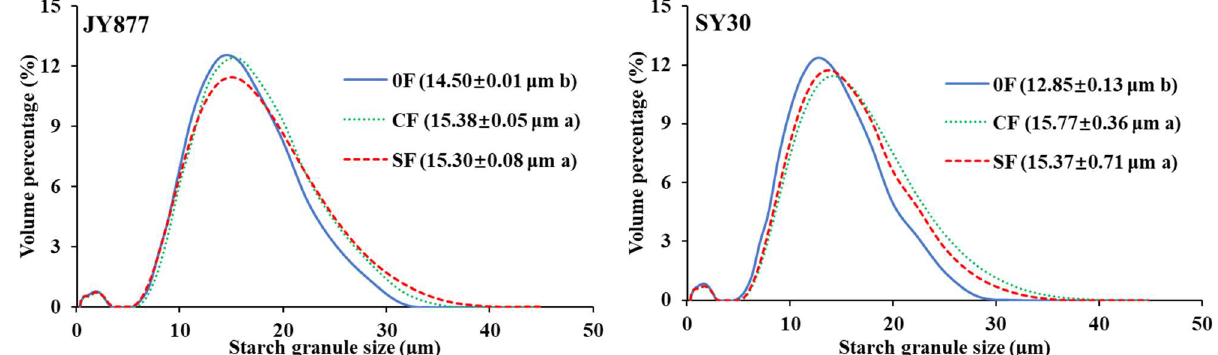
Figure 1. Effects of the fertilization mode on the starch granule size distribution of normal maize. The data in brackets are the average granule size. Mean values within the same hybrid followed by different letters are significantly different at p < 0.05. JY877, Jiangyu877; SY30, Suyu30; 0F, zero fertilization; CF, common fertilization; SF, slow-release fertilization.